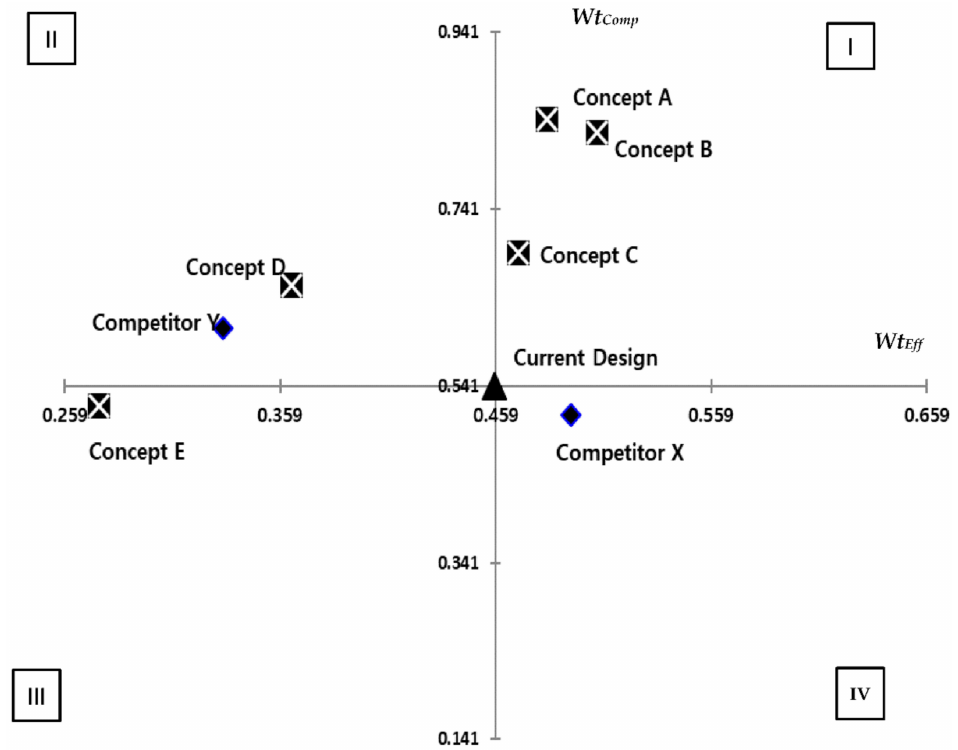
Figure 4. Quadrant analysis for design concept